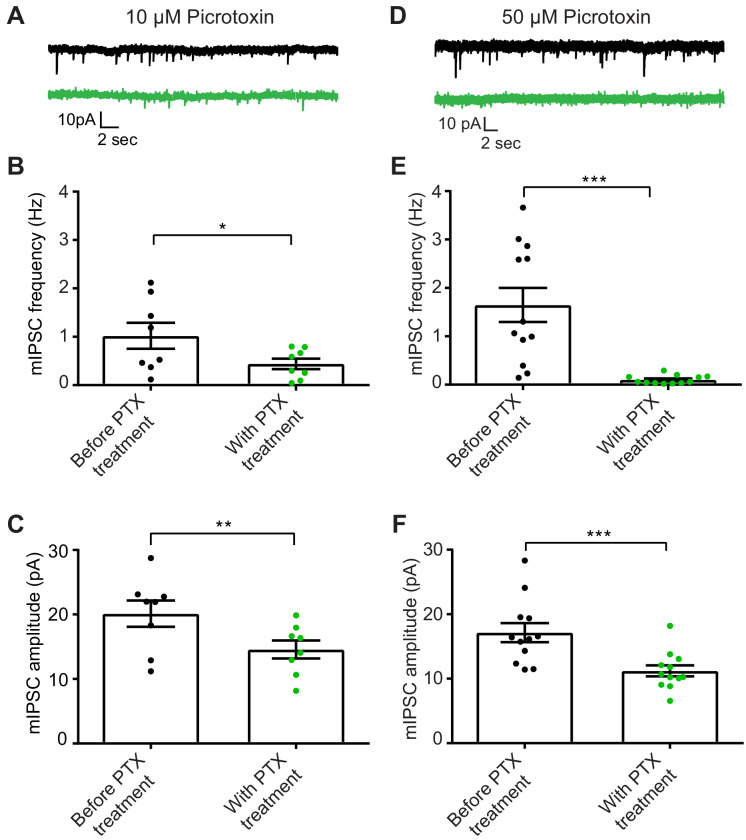
Examination of different doses of PTX.(A) Example traces of mIPSCs before (above) and after (below) treatment with 10 µM of PTX. (B) Quantification of mIPSC frequency before and after (8 min) treatment with 10 µM of PTX. Frequency is decreased following 10 µM PTX treatment (paired t-test t(7) = 3.213, p=0.0148, n = 8). (C) Quantification of mIPSC amplitude after (8 min) treatment with 10 µM of PTX. Amplitude is slightly decreased following 10 µM PTX treatment (paired t-test t(7) = 4.591, p=0.0025, n = 8). (D) Example traces of mIPSCs before (above) and after (below) treatment with 50 µM of PTX. (E) Quantification of mIPSC frequency before and after (8 min) treatment with 50 µM of PTX. Frequency is drastically decreased following 50 µM PTX treatment (paired t-test t(11) = 4.685, p=0.0007, n = 12). (F) Quantification of mIPSC amplitude after (8 min) treatment with 50 µM of PTX. For the few remaining events, amplitude is slightly decreased following 50 µM PTX treatment (paired t-test t(11) = 4.675, p=0.0007, n = 12). 50 µM of PTX blocks mIPSCs more fully than 10 µM of PTX. Graphs are mean ± SEM. * indicates p<0.05, ** indicates p<0.01, *** indicates p<0.001.Figure 1—figure supplement 1—source data 1.Source data for Figure 1—figure supplement 1.